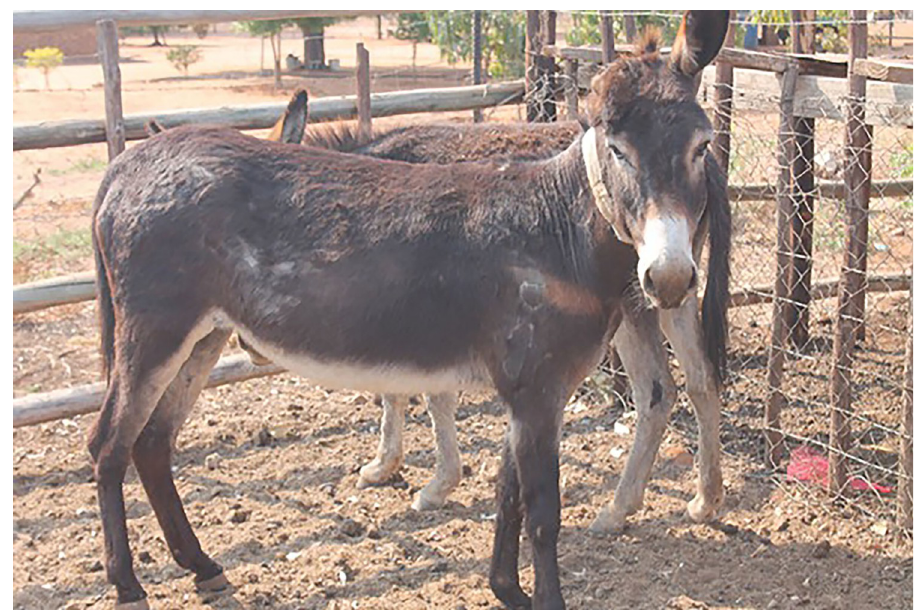
Fig 3. Dark brown donkey.